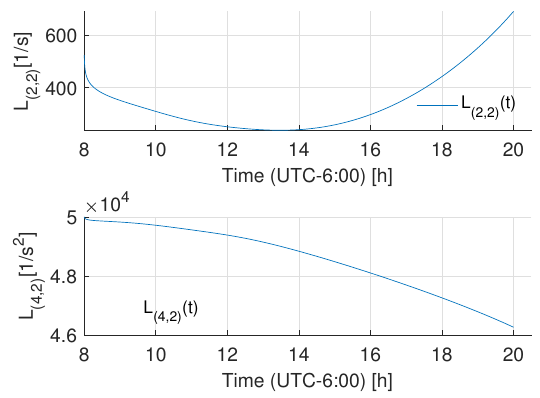
Figure 17. Observer gain behavior for the elevation axis